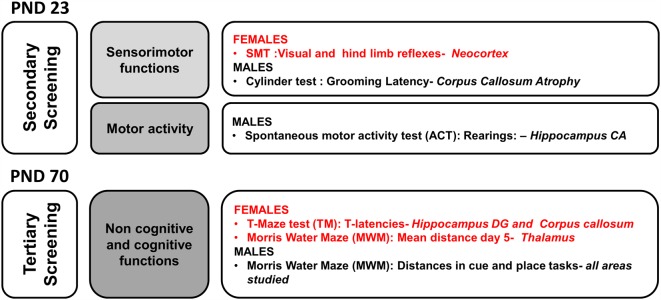
Neuroanatomical correlates of short- and long-term behavioral effects of HI in males and females C57BL/6 and those of NH. The graphical abstract summarizes the strongest neuroanatomical-behavioral correlations (P < 0.01) found in males (55 variables) and females (17 variables). This distribution, indicates that in spite of similar injury score, the NH was more effective restoring functions in males and that they were those related to the cognitive domains. In contrast, the domain of non-cognitive function was the more benefited in HI + NH females.